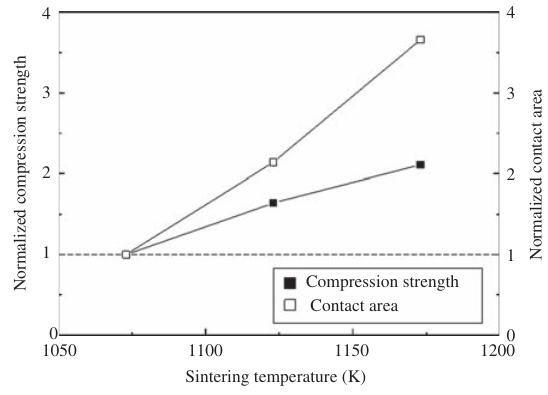
Figure 2 Effect of fabrication temperature on compression strength of CF preform and CF-Cu contact